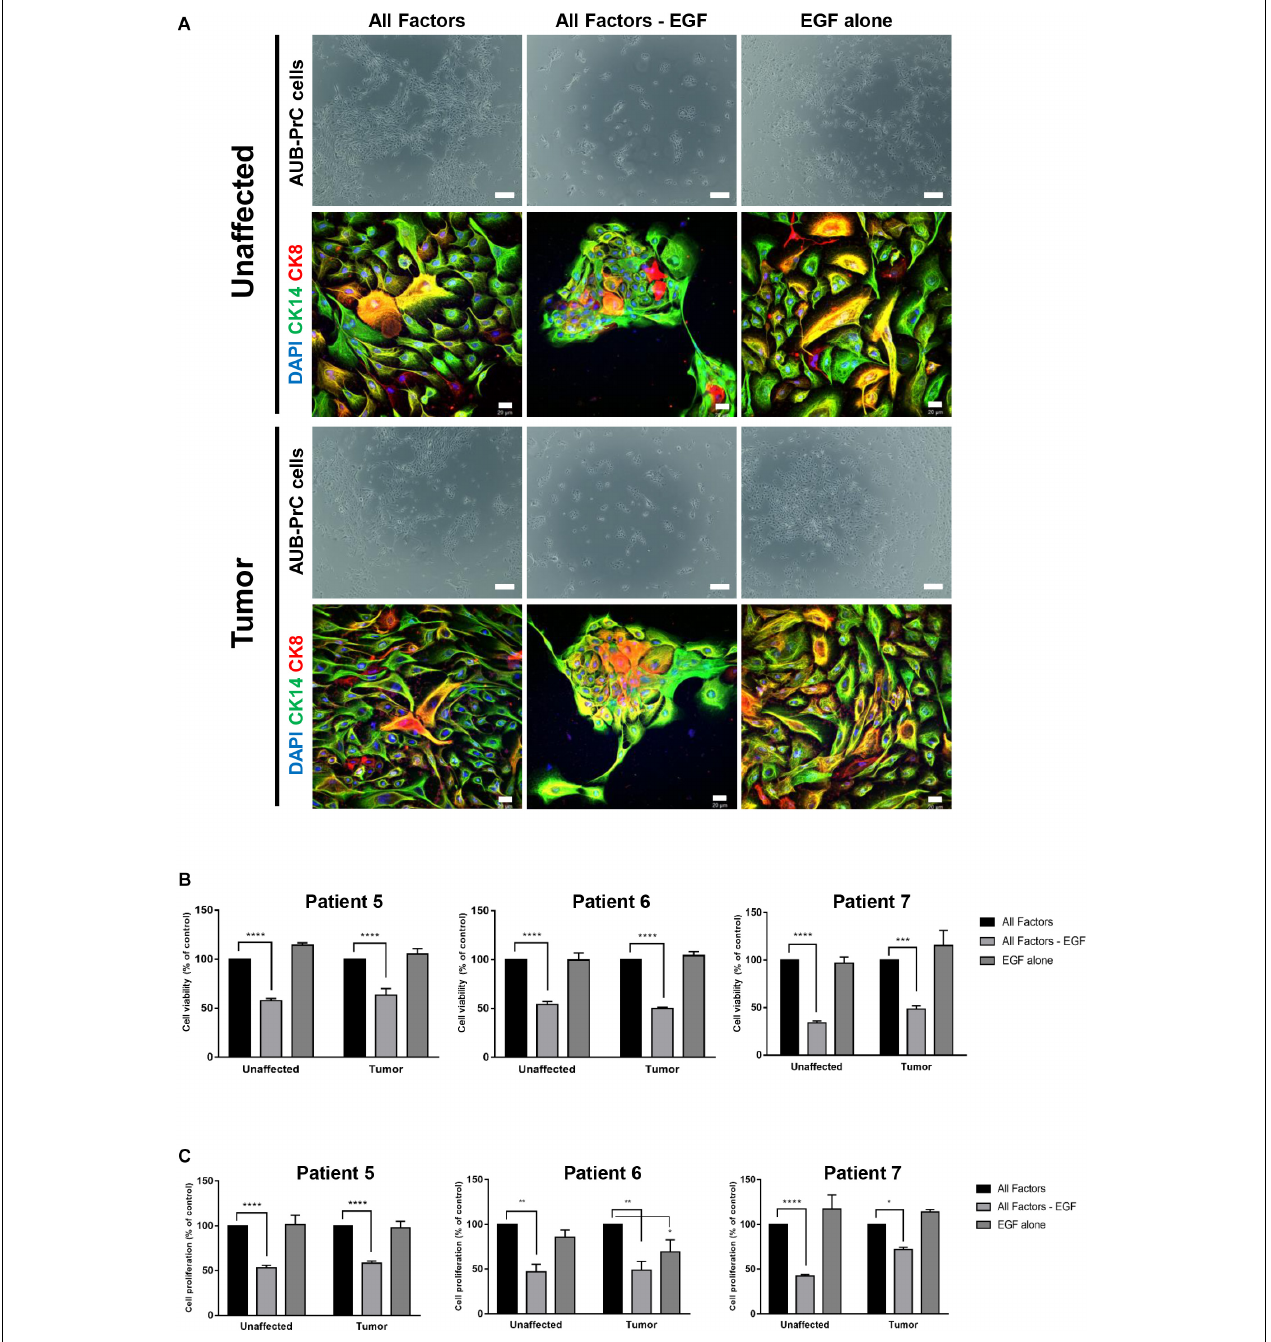
FIGURE 7 | EGF is essential to grow patient-derived AUB-PrC cells in culture. (A) Representative bright-field images of AUB-PrC cells established from unaffected and tumor organoids {patient 7 with Grade Group 3 [Gleason Score 7(4 + 3)]; patient characteristics in Supplementary Table S1 } and grown under different conditions; condition 1 “All factors” with prostate organoids growth medium, condition 2 “All factors -EGF” with prostate organoids growth medium without EGF, and condition 3 “EGF alone” with adDMEM/F12 with EGF only (10 ng/mL). Scale bar = 200 µ m. Representative Immunofluorescent images of AUB-PrC cells {patient 7 with Grade Group 3 [Gleason Score 7(4 + 3)]; patient characteristics in Supplementary Table S1 } grown under different conditions as described previously are stained with the prostate lineage epithelial markers CK8 and CK14. The nuclei were stained with anti-fade reagent Fluorogel II with DAPI. The images were acquired using the Zeiss LSM 710 laser scanning confocal microscope (Zeiss), and images were processed using the Carl Zeiss ZEN 2013 image software. Scale bar = 20 µ m. (B) Cell viability was determined using the trypan blue exclusion assay. (C) Cell proliferation was determined in triplicates using the MTT cell proliferation assay {patient 5 with Grade Group 3 [Gleason Score 7(4 + 3)]; patient 6 with Grade Group 2 [Gleason Score 7(3 + 4)]; patient 7 with Grade Group 3 [Gleason Score 7(4 + 3)]; patients characteristics in Supplementary Table S1 }. Data represent an average of triplicate measurements and are reported as mean ± SEM. (Two-way ANOVA; * P < 0.05, ** P < 0.01, *** P < 0.001, **** P < 0.0001; different conditions compared to condition 1 “All Factors,” Bonferroni’s multiple comparisons test).